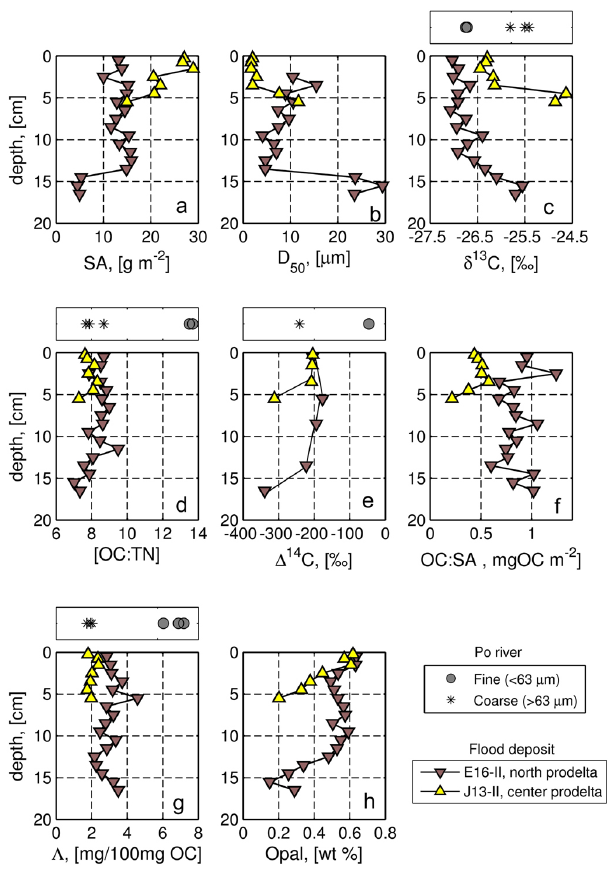
Fig. 8. Down-core variability in flood deposits collected in the northern (E16-II) and central (J13-II) prodelta vs. material collected in the Po river: (a) SA (Surface Area), (b) D 50 , (median grain size) (c) δ 13 C, (d) OC:TN, (e) 1 14 C, (f) OC:SA, (g) 3 , and (h)